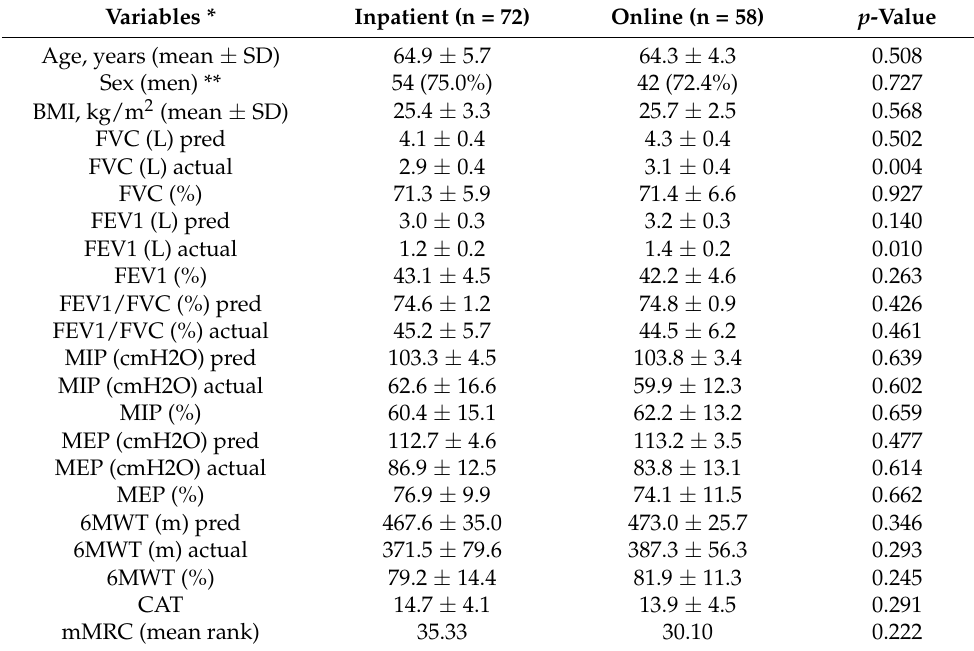
Table 4. Comparison of post-test results between inpatients and online participants. Variables